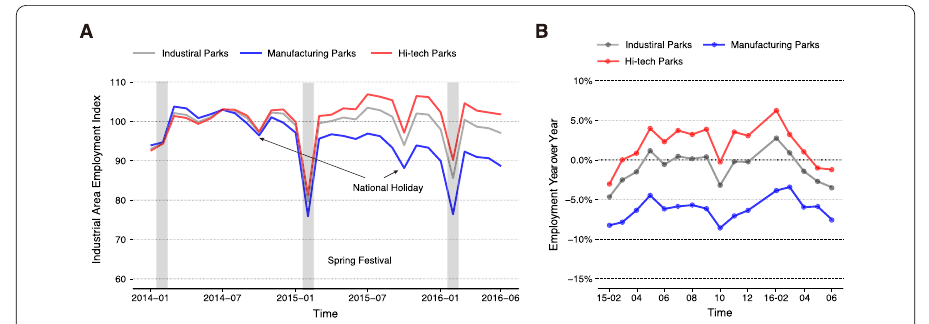
Figure 3 Employment index for industrial parks. (A) The grey line shows the overall trend among all 2,000 industrial parks, which is relatively steady with a slow decline. The blue line, which represents the result for approximately 1,000 manufacturing industrial parks, shows a sustained and more obvious downward trend; the red line, which represents the result for approximately 1,000 high-tech parks, shows healthy